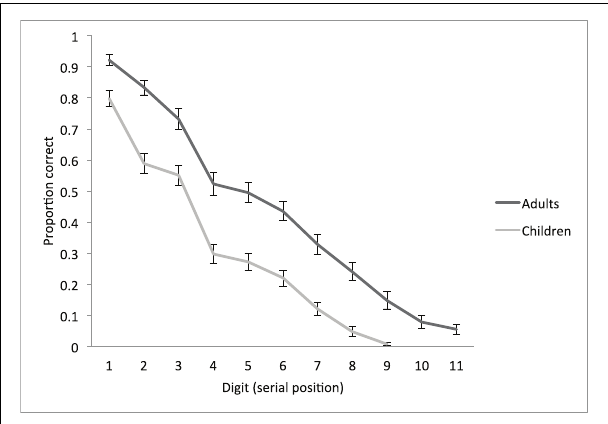
FIGURE 1 | Behavioral performance on the STM overload task. Mean proportion of digits correctly recalled as a function of serial position, plotted separately for children and adults. Error bars represent standard mean